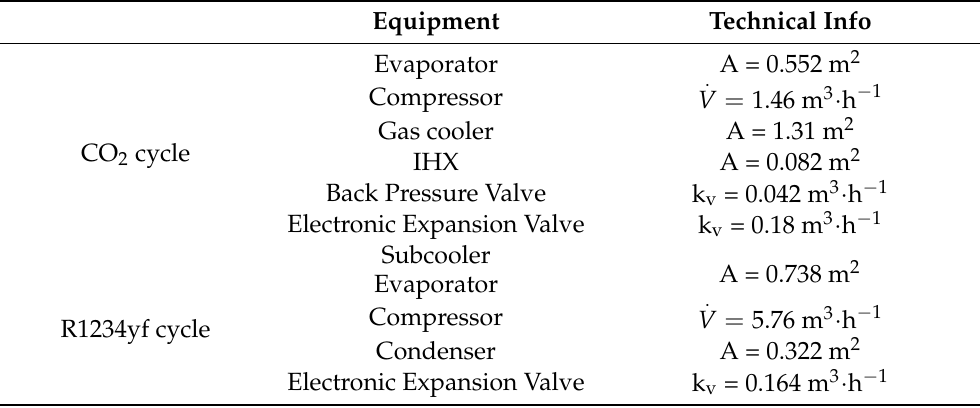
Table 1. Characteristics of the elements of the cycles